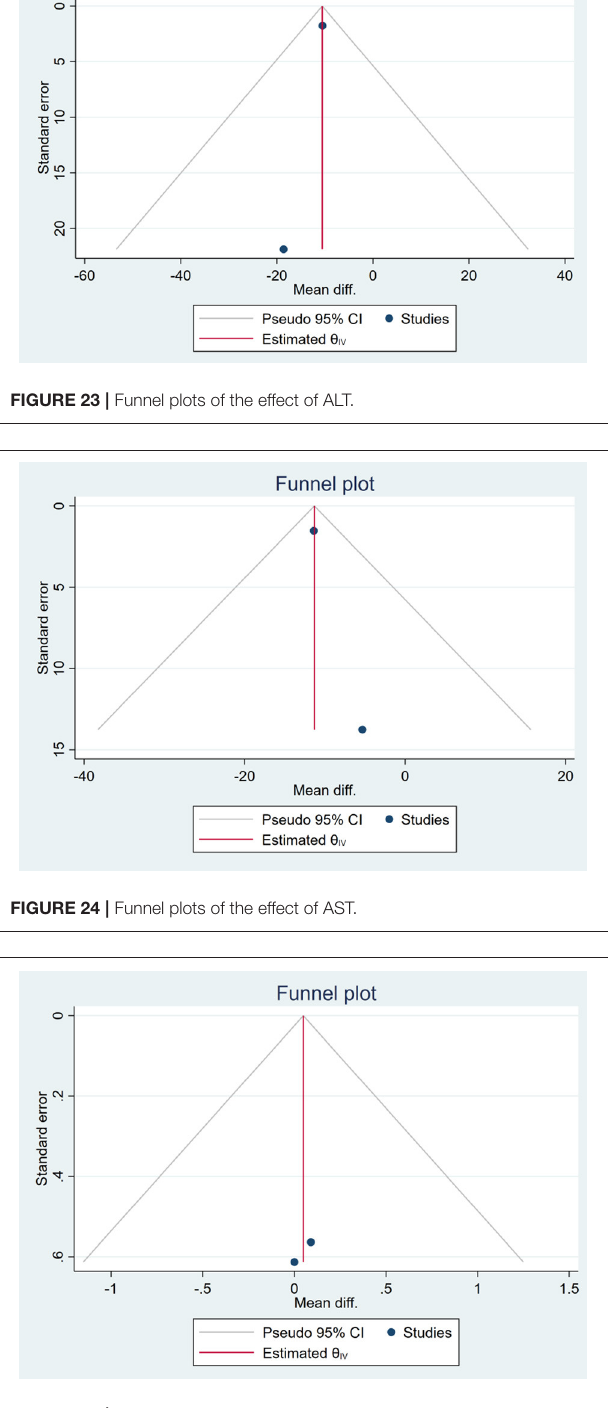
FIGURE 25 | Funnel plots of the effect of liver